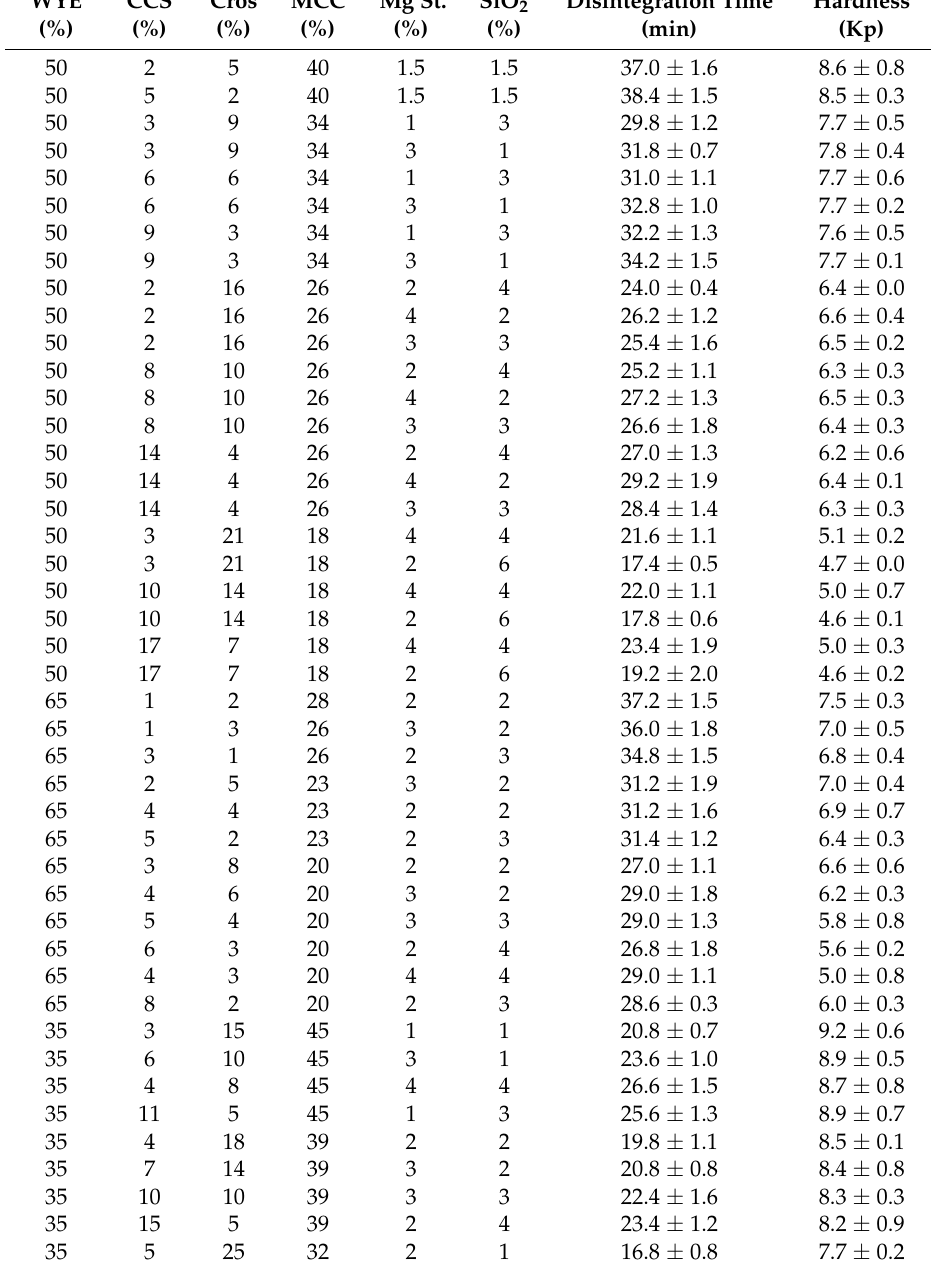
Table 8. Experimental design of Wuzi Yanzong extract tablet formulation with control factors (%, w / w ) and the resulting response, disintegration time, and hardness for partial least squares (PLS)